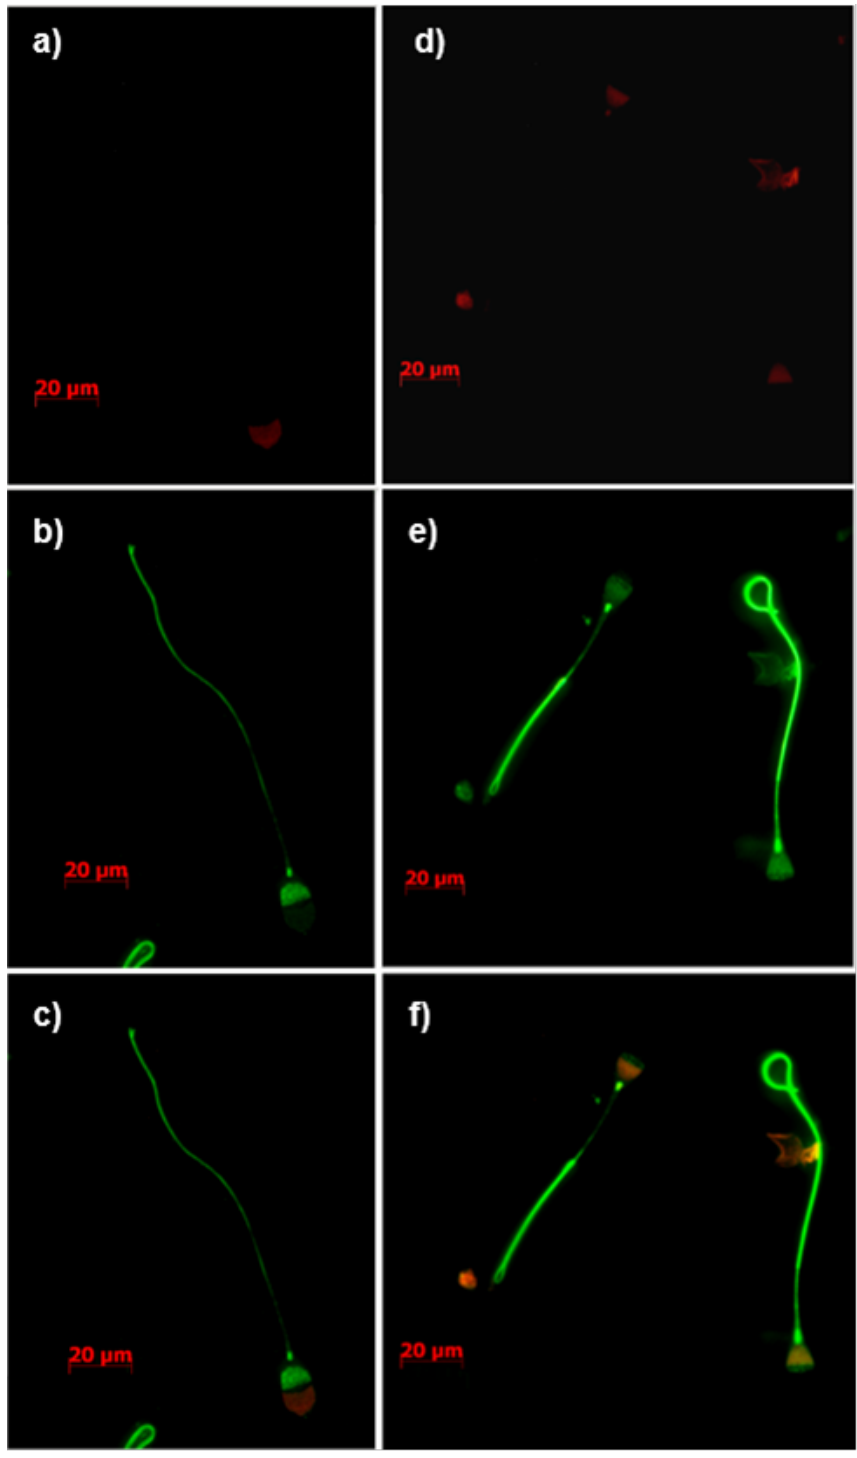
Figure 4. Immunolocalization of ATP1A4 ( a , d ; red), β -tubulin ( b , e ; green), with overlaid merges of red and green channels ( c , f ) in fresh (0 h control) ( a – c ) and capacitated ( d – f ) bovine sperm. Images were captured using an inverted phase contrast fluorescence microscope (Zeiss Axio Observer Z1) equipped with Axiocam MRc5 using a 100× oil-immersion objective lens. The secondary antibody controls (incubation without anti-tACE, anti- β -tubulin, and anti-ATP1A4) with associated phase contrast images were shown in Figure